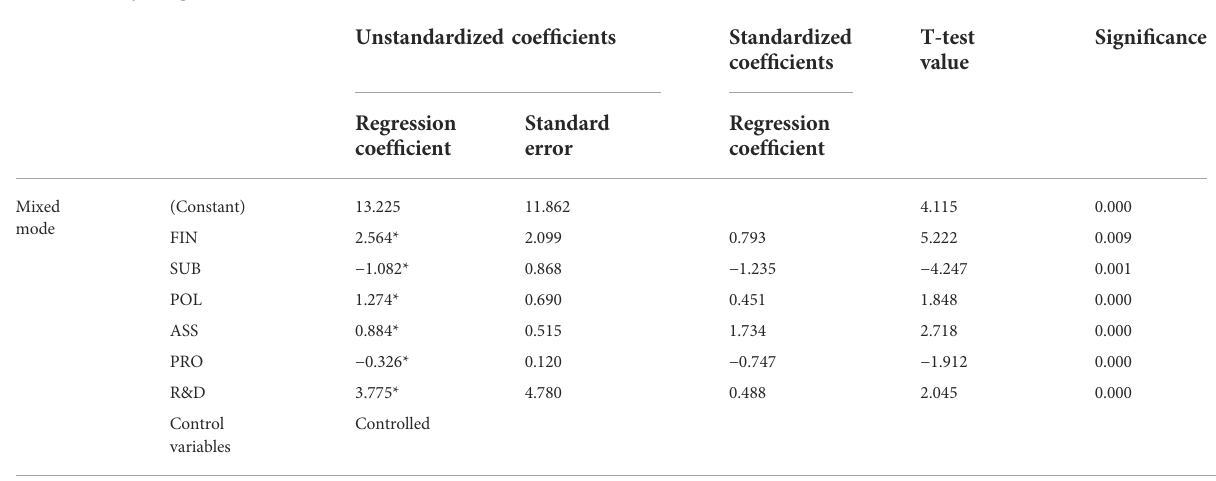
TABLE 6 Multiple regression coef fi cients of mixed-mode